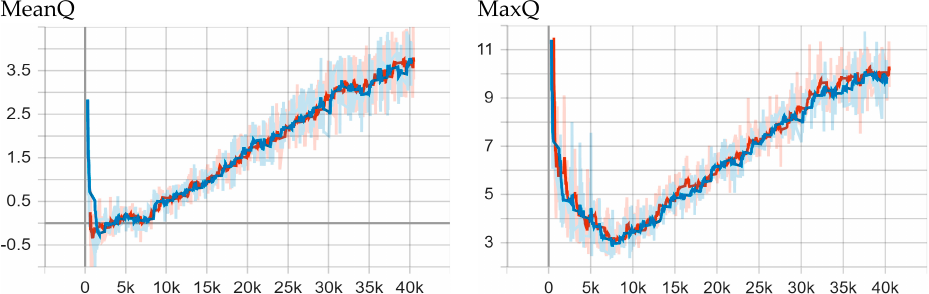
Figure 7. The average predicted action value of the MeanQ ( left ) and MaxQ ( right ) values with two colored lines (red—target and blue—DQN value loss). The MeanQ figure (left) represents the variation values of the average Q on the y axis along with the number of training epochs, and MaxQ on the right figure shows the maximum achieved Q value variation while training on the y axis jointly with the number of epochs on the x axis. Shadow variables are copies of the main train variables that are used to maintain the moving average. The idea is that they follow the main variable like a shadow.